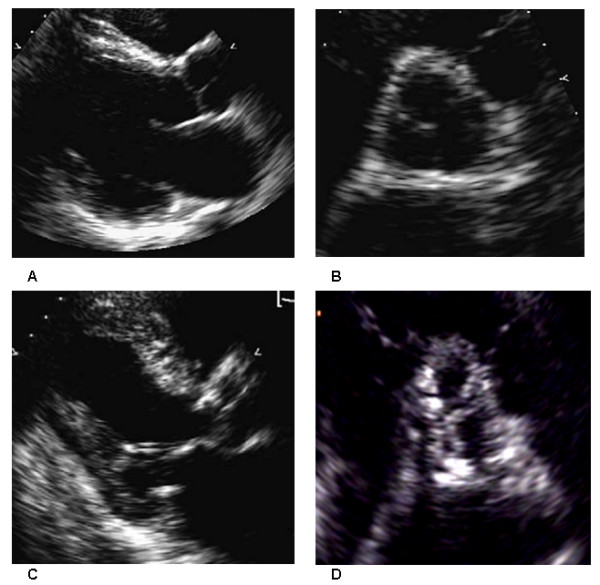
A – B – C – D Accordingly to the absence and presence cardiac calcifications identified, final score was calculated expressing the sum of all: it was in the range from 0 (no calcium visible) to 8 (severe calcification of aortic valve and mitral annulus, presence of calcium at the level of ascending aorta and papillary muscles). A – B No calcifications are visible at the level of aortic valve with a total calcium score of 0/8. C – D Calcifications are evident at multiple sites: mitral annulus, papillary muscles, aortic valve and ascending aortic wall with a total calcium score of 8/8.